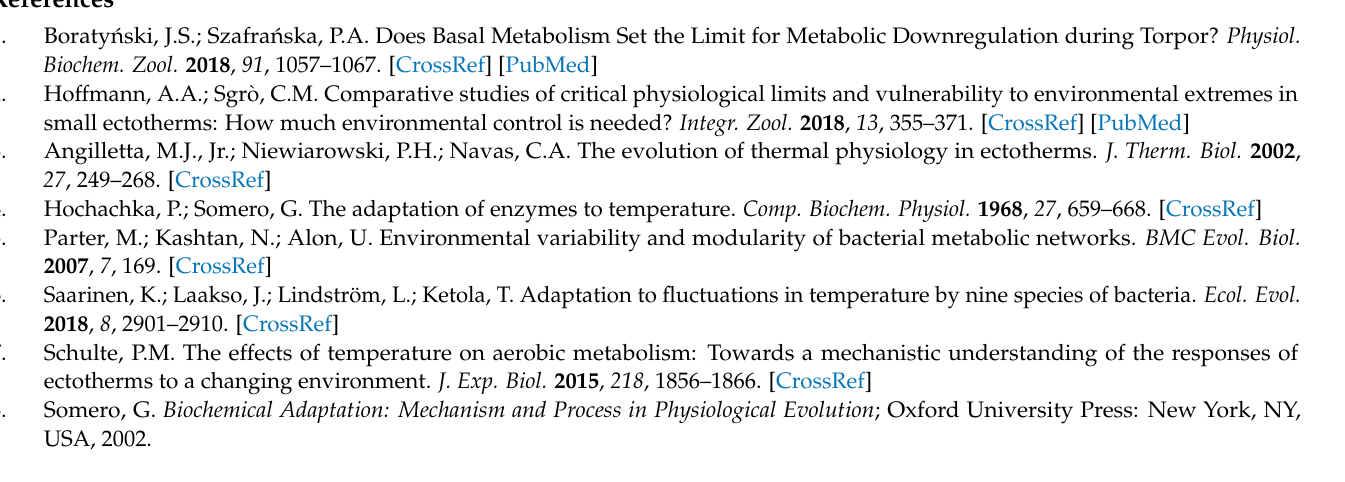
Figure S4: The heart rate for the dissected background and expression of TrpA1-RNAi in mesoderm for larvae raised at 21 ◦ C and 27 ◦ C for exposure to 37 ◦ C. The heart rate showed a lot of variation upon the initial exposure to 37 ◦ C for most of the strains; however, after two and half minutes the rates generally decreased for all the strains. The UAS-TrpA1-RNAi#2, 24>TrpA1-RNAi#2, UAS-GFP and 24B>GFP strains showed a lot of variation upon exposure 37 ◦ C for being raised at 21 ◦ C or 27 ◦ C. There is no significant difference from background strains compared to the ones crossed to the 24B strain. Figure S5: The heart rate for the dissected strains expressing TRPA-RNAi in heart specific tissue. The heart rate increased in Hand4.2>TrpA1-RNA#1 (A1, A2) and Tinc>TrpA1-RNAi#1 (B1, B2) from 21 ◦ C to at 30 ◦ C ( p < 0.05, Paired t -test) for both conditions of larvae raised at 21 ◦ C (A1,B1) as well as at 27 ◦ C (A2,B2). The stains Hand4.2>TrpA1-RNAi#1 (A3, A4) and Tinc>TrpA1-RNAi#1 (B3, B4) upon initial exposure at 37 ◦ C showed quite a bit of variation. However, at 37 ◦ C after 2 and half minutes all rapidly decreased heart rate. The same trends were present for the larvae raised at 21 ◦ C (A3,B3) as well as at 27 ◦ C (A4,B4). There is no significant difference from background strains compared to the ones crossed to the heart specific strains. Figure S6: Controls for the expression of the RNAi strains crossed with the W118 strain for dissected preparations. The UAS-TrpA1-RNA#1/+ showed similar trends as UAS-TrpA1 in an increase in heart rate at 30 ◦ C. The 24B>TrpA1-RNAi#1 as well as the backgrounds and controls (UAS-TrpA1-RNAi#1, UAS-TrpA1-RNAi#2, UAS-GFP, and 24B>GFP) all showed variation upon initial exposure to 37 ◦ C and showed a decrease after two and half minutes at 37 ◦ C. No significant difference occurred among the